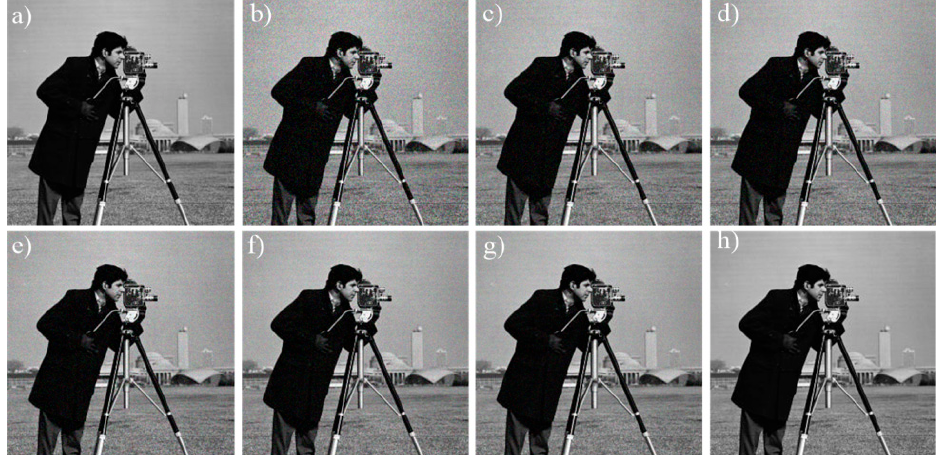
Figure 13. Recovery effect of the six methods on the Cameraman image. ( a ) original image; ( b ) noisy image; ( c ) OMP; ( d ) StOMP; ( e ) BP; ( f ) L0GP; ( g ) L0MN; ( h ) L0RCD. Table 2. The quantitative results (signal to noise ratio (SNR) / Time consumption(s)) of the six algorithms. Algorithm